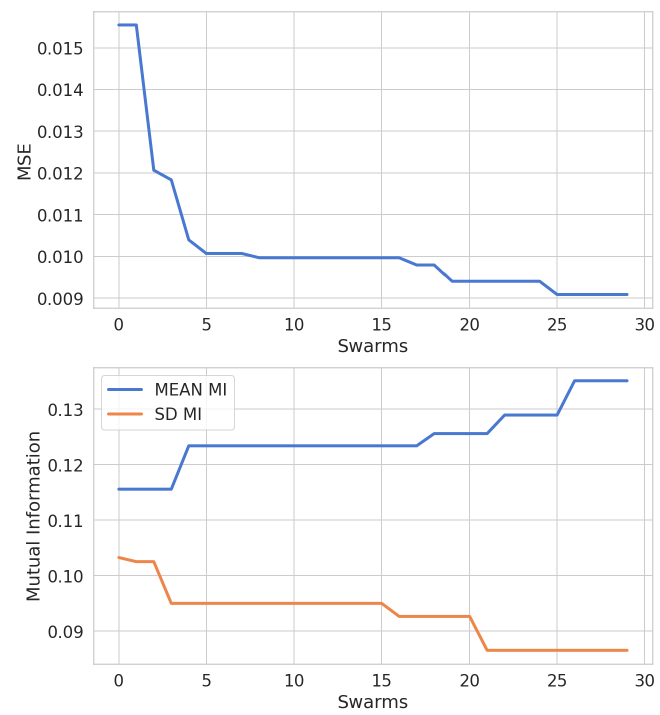
Figure 5. MSE, mean, and sd MI between input representations and output variables for the debutanizer